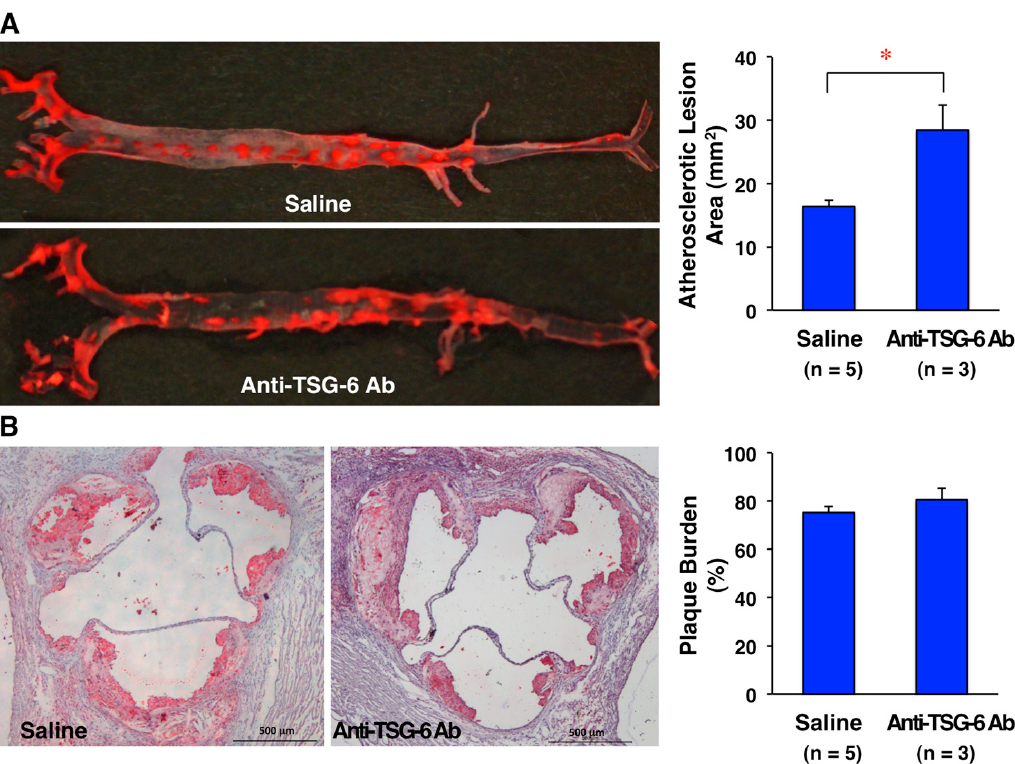
Figure 3. Effects of endogenous TSG-6 decreases on the development of atherosclerotic lesions in ApoE-deficient mice. Four-week infusion of an anti-TSG-6 neutralizing antibody (50 μ g/mouse, R&D Systems, Minneapolis, MN, USA) or saline (control) using osmotic mini-pumps was performed in 17-week-old ApoE-deficient mice fed a high cholesterol diet. Atherosclerotic lesions were stained with Oil Red O (Wako Pure Chemical Industries, Osaka, Japan). The atherosclerotic lesions were measured in the whole aortic tree. Plaque burden is expressed as a percentage relative to the entire cross section of the aortic sinus wall. Bar = 500 µ m. Atherosclerotic lesions in the entire aortic surface area ( A ) and plaque burden ( B ) are increased in mice infused with anti-TSG-6 neutralizing antibody ( n = 3) than those infused with saline ( n = 5). Data are presented as mean ± SEM. Unpaired Student’s t test was used for statistical analysis. ( A ) * p = 0.0085; ( B ) p = 0.3124. These results are unpublished data from our new